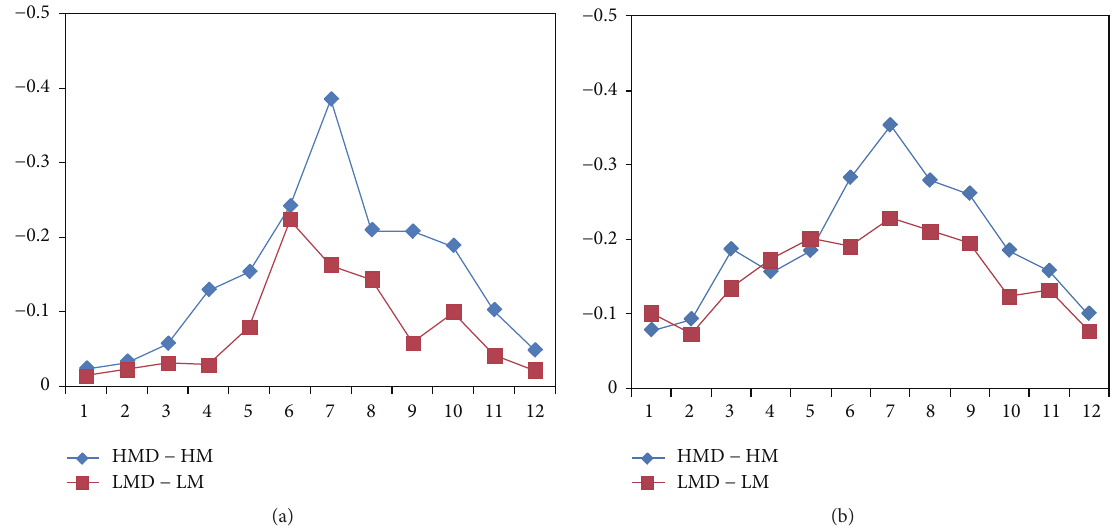
Figure 15: Regional mean water vapor mixing ratio (gkg −1 ) at 850 hPa averaged in the rainy season (May to August) in north China (a) (38 ∘ –42 ∘ N, 110 ∘ –120 ∘ E) and south China (25 ∘ –30 ∘ N, 110 ∘ –115 ∘ E) in the four different